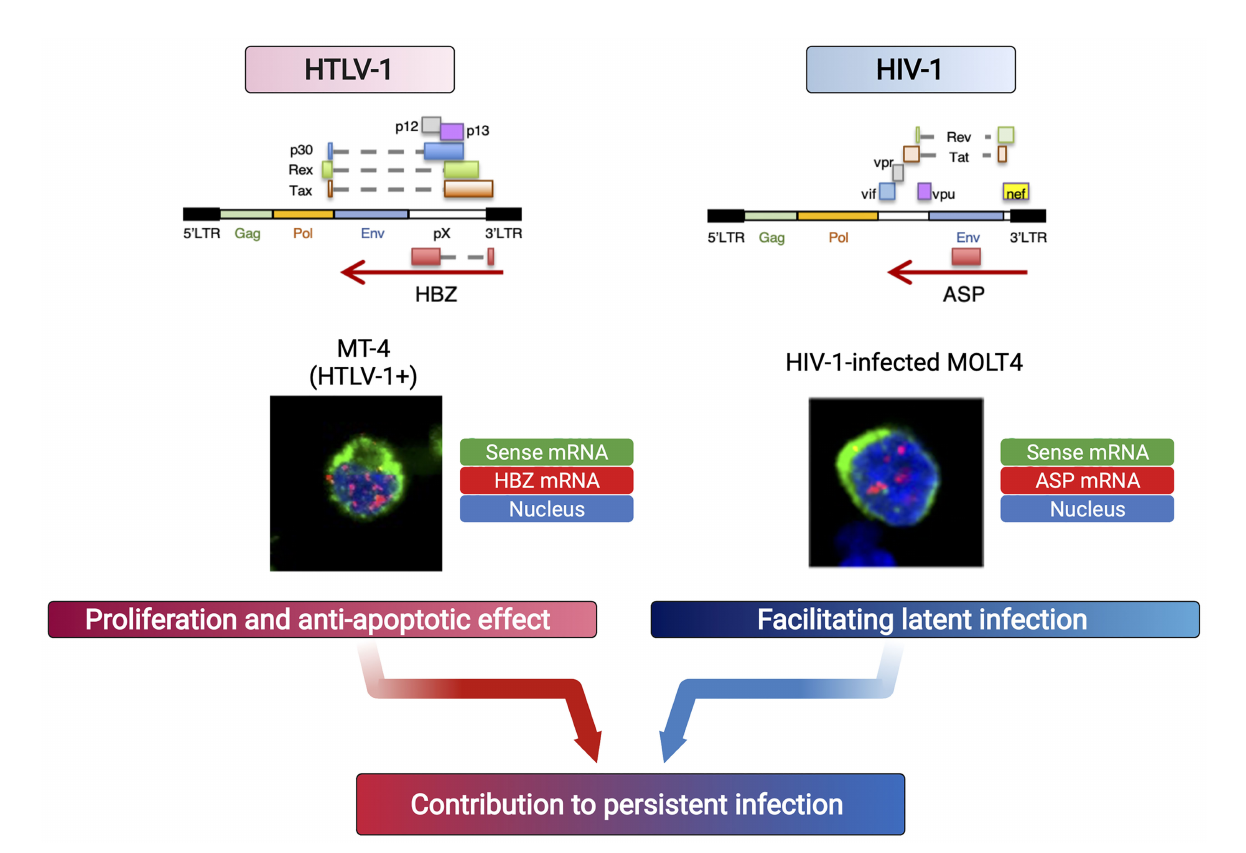
FIGURE 2 | Retroviral antisense mRNAs persist in the nucleus and function like lncRNAs. Due to insuf fi cient polyadenylation, human retroviral antisense transcripts remain in the nucleus. Each mRNA acts differently to affect the survival of the infected cells (HTLV-1) or viral latency (HIV-1, HTLV-1), leading to persistent infection